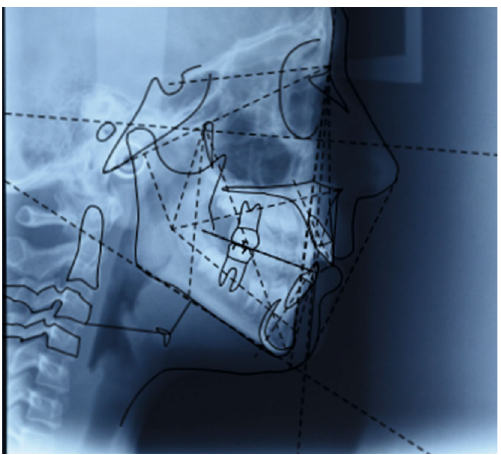
Figure 4: Initial lateral